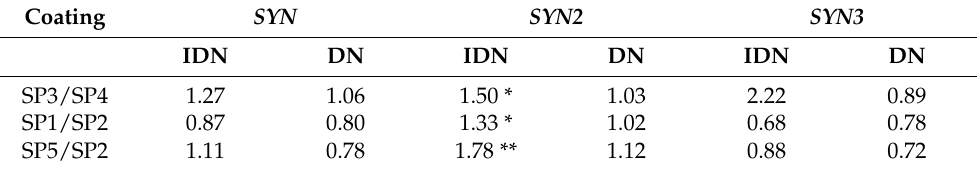
Table 6. Effect of the presence of various BAPs in CCs on synapsin gene expression in IDN and